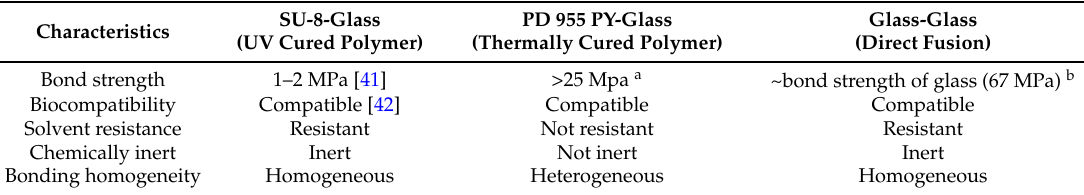
Table 2. Comparison of characteristics between indirect (SU-8-glass, PD 955 PY-glass) and direct (glass-glass) bonding